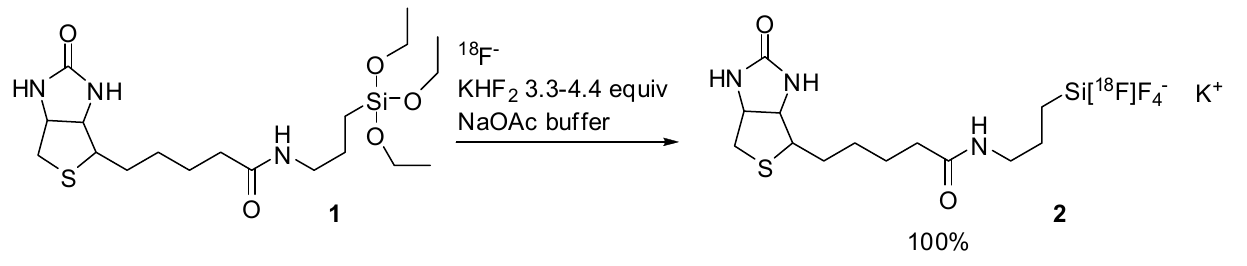
Figure 2. Radioactive 18 F-labeling of 1 yielding the [ 18 F]tetrafluorosiliconate “ate” salt 2 in quantitative yields in aqueous buffered